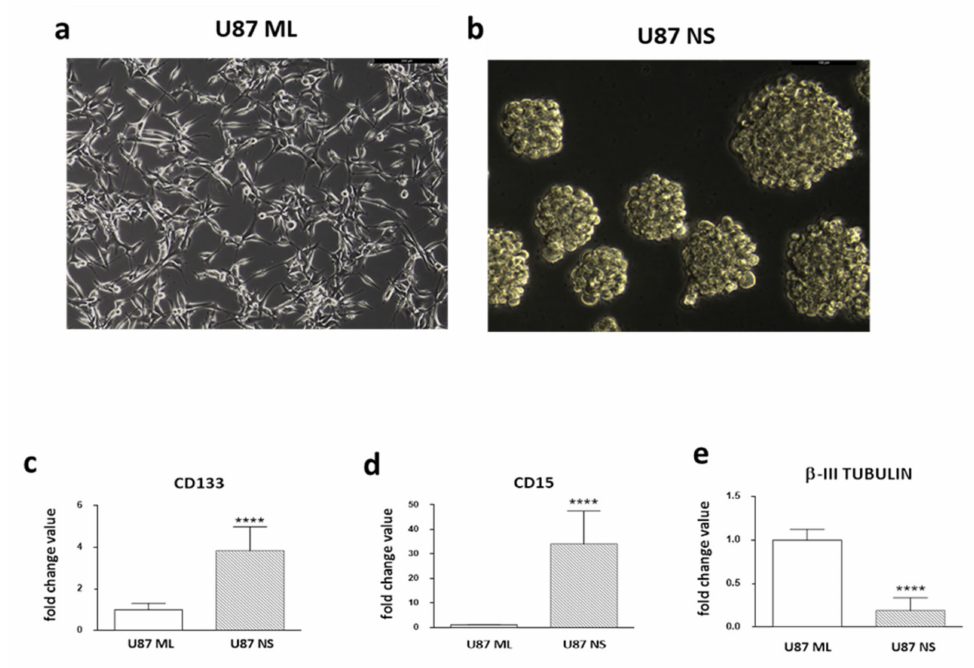
Figure 1. Analysis of stemness/differentiation markers in U87 ML and U87 NS. ( a ) Representative images of U87 cells grown in standard medium as a monolayer. ( b ) Neurospheres grown for 7 days in a selective medium. ( c , d ) CD133 and CD15 mRNA expression levels, considered stemness markers, and ( e ) β -III TUBULIN , a well-known marker of neuron differentiation in U87 ML and NS cells. Data are shown as relative expression compared to U87 ML. p values were determined using a two-tailed t test, **** p <